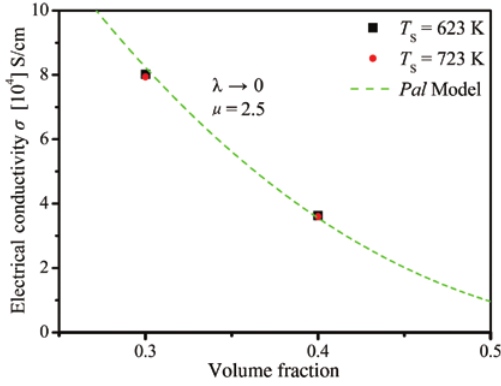
Figure 7: Experimental data of electrical conductivity and curve calculated by assuming Pal ’s theoretical model for Mn Zn Sn N/Al 3 0.5 0.5